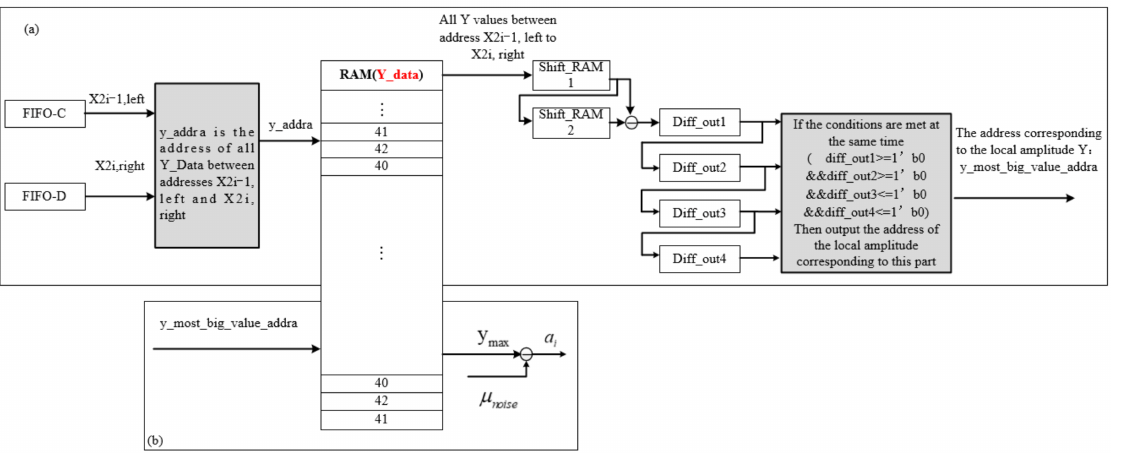
Figure 12. The calculation for the amplitude of each Gaussian component: ( a ) Solving for the maximum value, y max ; ( b ) Solving for the amplitude a i